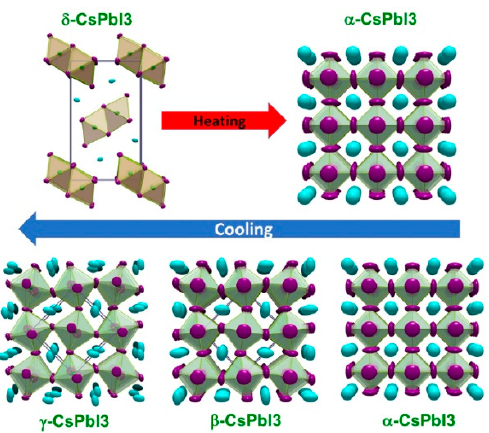
Figure 1. Four different structural phases of CsPbI 3 and their phase transitions reprinted with permission from Ref. [39] 2018 American Chemical Society.